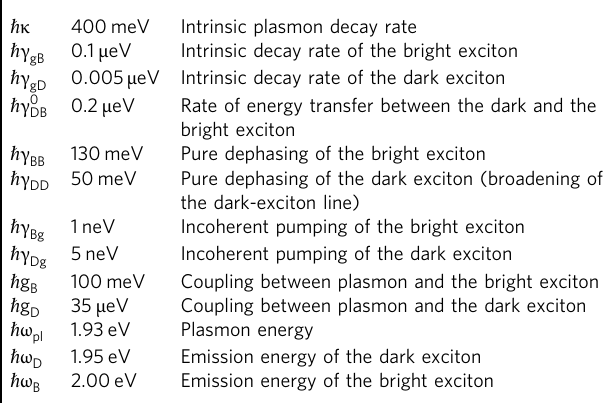
Table 1 Set of parameters used to reproduce spectra and g ð 2 Þ t ð Þ functions, as shown in Fig.